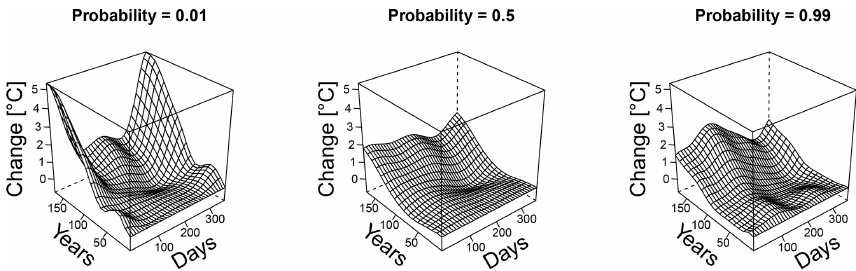
Figure 5. Differences between the two quantile maps (LENS minus SFK15) near Seattle as a function of years elapsed since 1920 and day of the year. At year zero, the quantile maps both produce zero change since the initial and final time are the same. As the years increase, so does the discrepancy between the two projections. Each panel shows these temperature discrepancies for a given non-exceedance probability of the temperature estimate. A positive change indicates a larger value for LENS than for the SFK15 ensemble. Notice the complex patterns both in long-term and seasonal effects, justifying the need for a model that fits all seasons